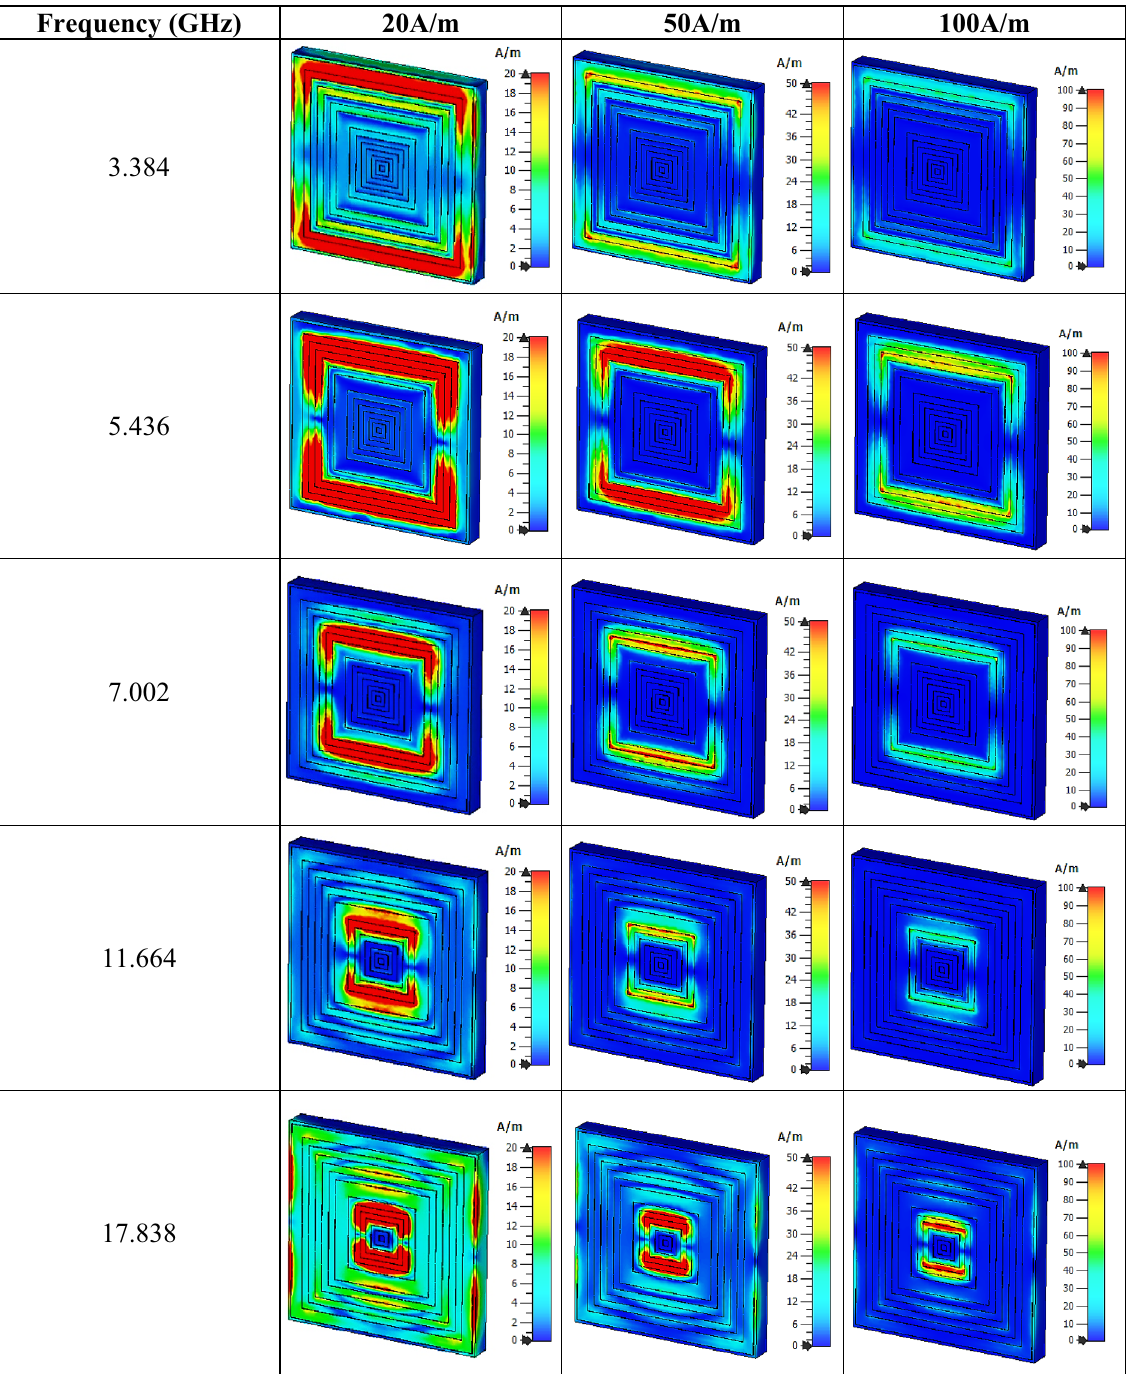
Table 3. Magnetic field distribution of the proposed metamaterial design for three field